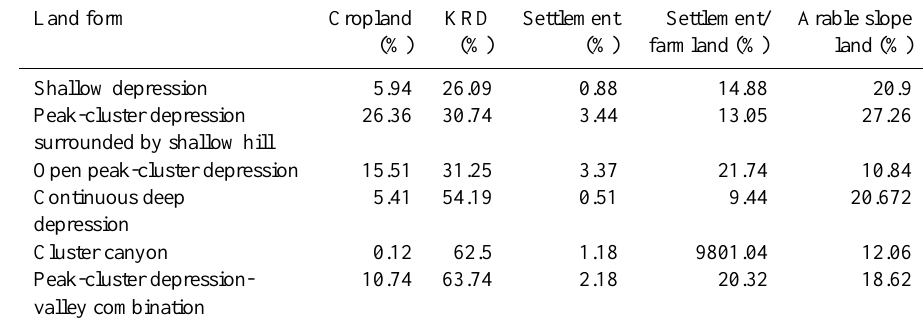
Table 2. Percentage of cropland, settlements and KRD desertified land (including light, moderate, severe KRD). Land form Cropland KRD Shallow